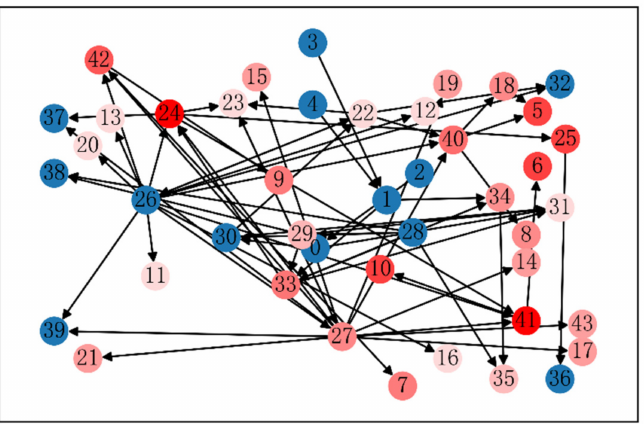
Figure 11. CRE results of the probability propagation model (the closer the node is to blue means its CRE is close to 0, and the closer it is to red means its CRE is